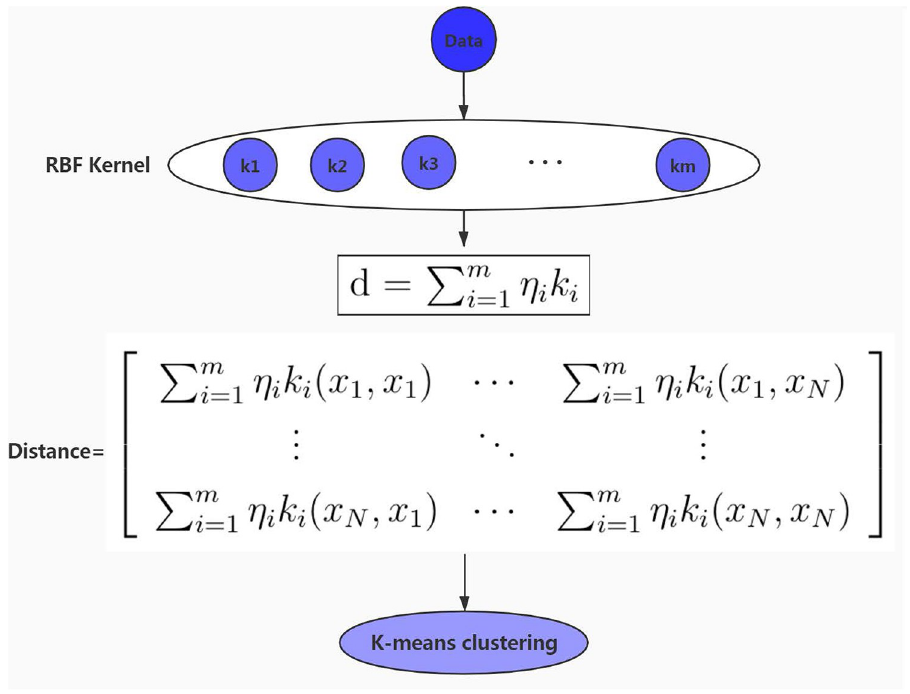
Fig 4. Multiple kernel k-means